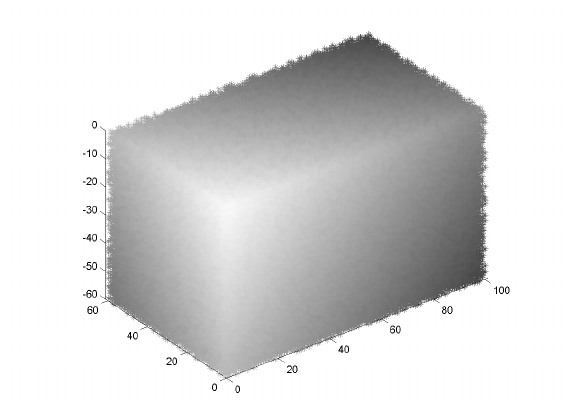
Figure 3: Nanorod with rough surface. Each dipole is rep- resented by a